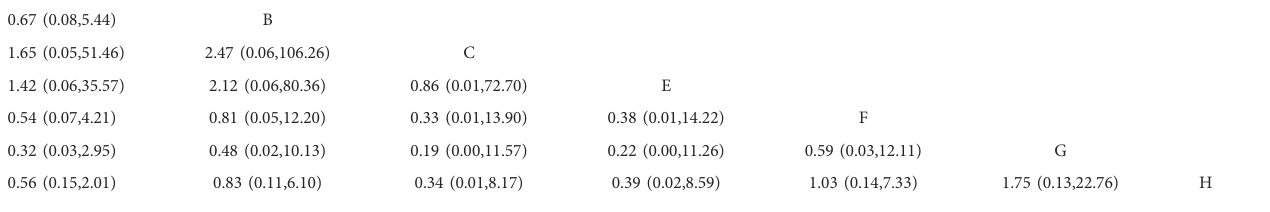
TABLE 5 Network meta-analysis results of DVT rates (RR, 95% CI).